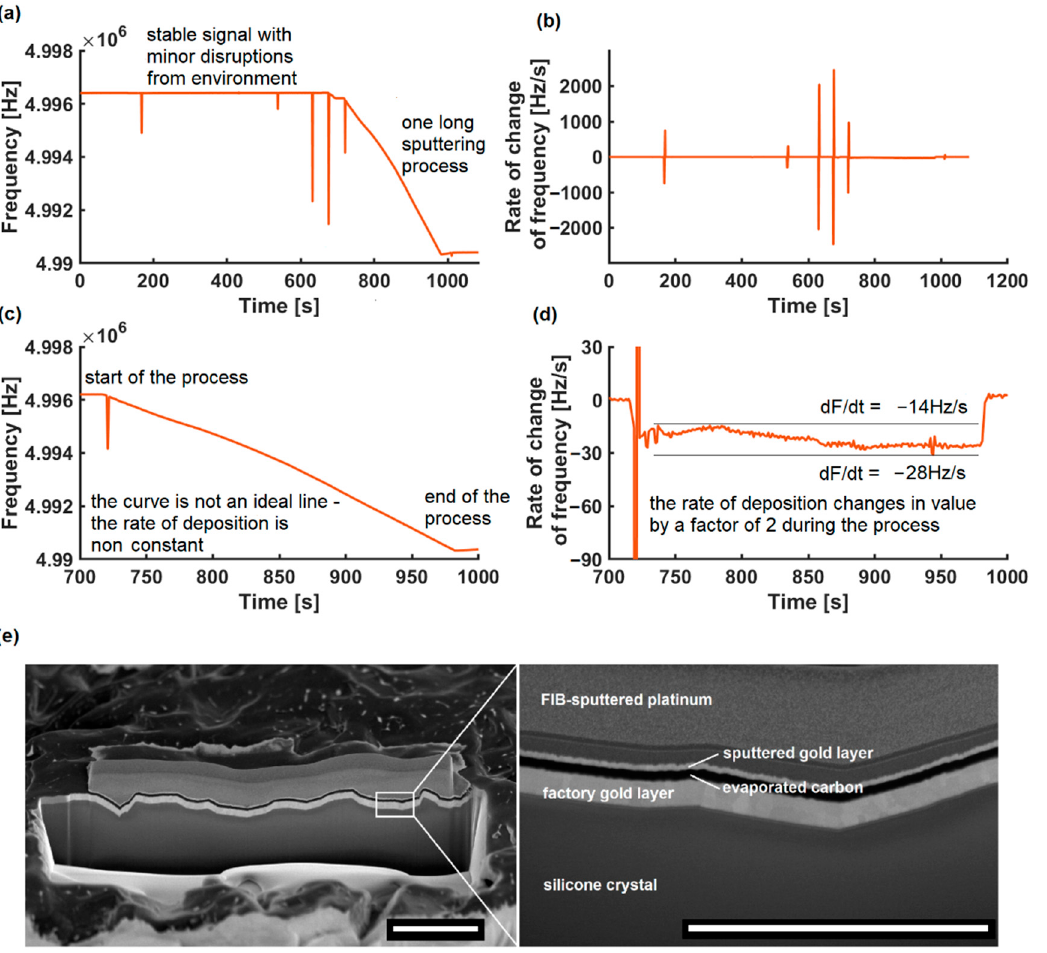
Figure 3. The comparison of sputtering process on QCM measurement and FIB-SEM imaging: ( a ) measured frequency; ( b ) the rate of change in the sputtering process presented on ( a ); ( c ) magnified view for time t = [700, 1000] s, showing the one deposition stage; ( d ) non-constant rate of change during deposition in the time interval; ( e ) FIB-SEM cross section of examined quartz crystal made after the experiment, scalebar 2 µm.